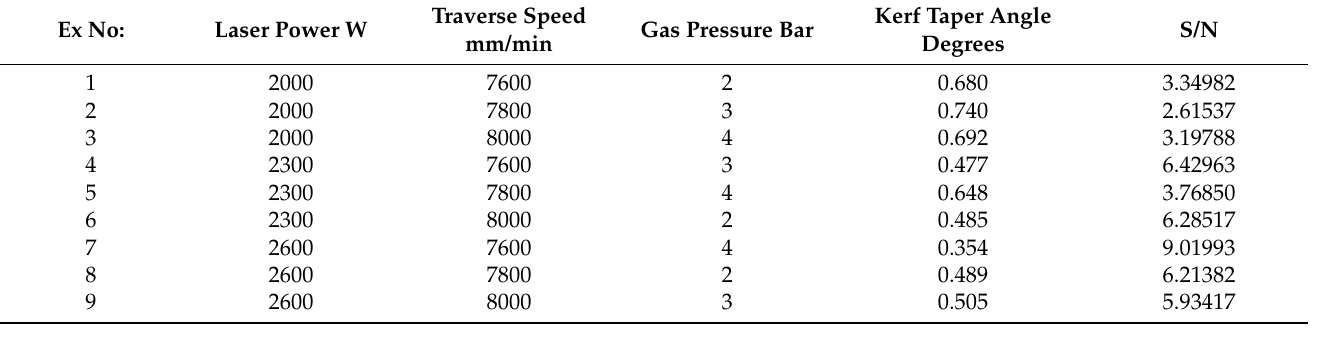
Table 13. L9 array of input parameter levels with measured Kerf taper angle θ ° in degrees and calculated signal-to-noise (S/N) ratio based on the Taguchi method for 6 mm specimen thickness.